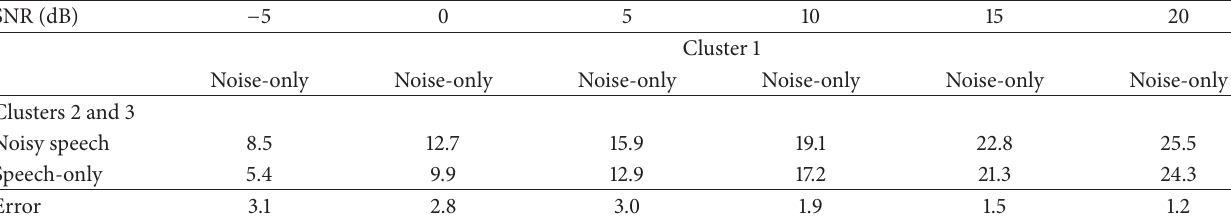
Table 4: The Euclidean distance between the three